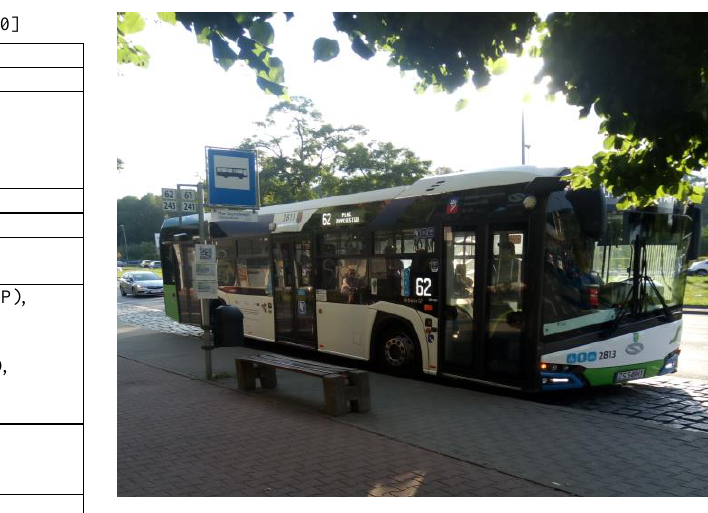
Fig. 2. Solaris Urbino 12 bus